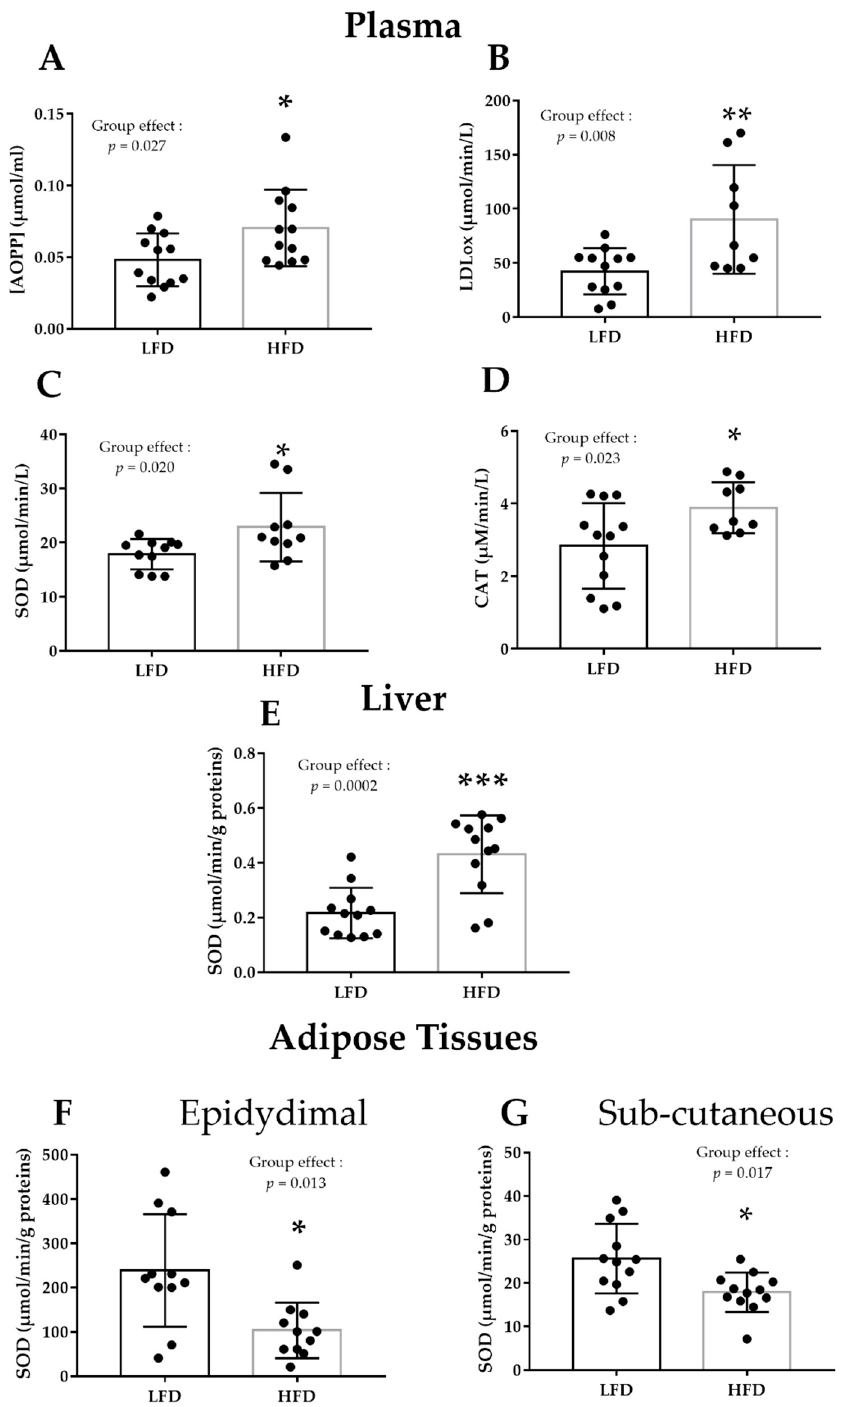
Figure 2. Pro/antioxidant markers in the LFD ( n = 12) and HFD ( n = 12) groups at the end of phase 2 (obesity induction with the HFD for 16 weeks). ( A ) Plasma AOPP concentration ( μ mol.mL − 1 ), ( B ) plasma oxLDL activity ( μ mol. − 1 min.L − 1 ), ( C ) plasma SOD activity ( μ mol. − 1 min.L − 1 ), ( D ) plasma CAT activity ( μ mol. − 1 min.L − 1 ), ( E ) liver SOD activity ( μ mol. − 1 min.L − 1 ), and SOD activity ( μ mol. − 1 min.L − 1 ) in ( F ) epididymal ( G ) and subcutaneous adipose tissue in the LFD and HFD groups. Data are the mean ± SD. * p < 0.05, ** p < 0.01, *** p < 0.001, compared with LFD ( t -test). •: indicates the measured values of the individual rats. AOPP: advanced oxidation protein products, CAT: catalase, HFD: high fat diet, HIIT: high-intensity interval training, LFD: low fat diet, oxLDL: oxidized low-density lipoprotein, SOD: superoxide dismutase.